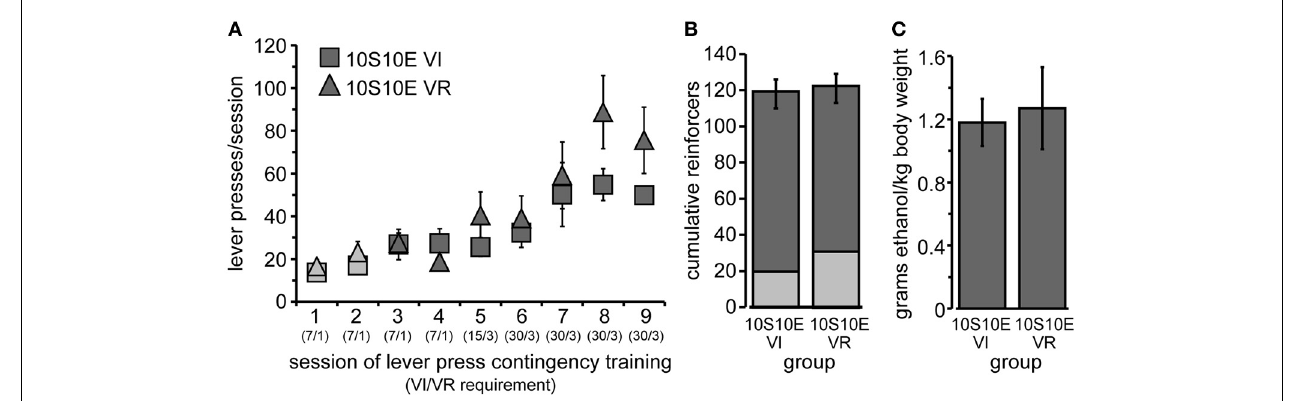
FIGURE 1 | Training of 10S10E groups. (A) Lever pressing increased similarly across training sessions for the two groups, 10S10E VI (squares) and 10S10E VR (triangles). Symbols for 10S-reinforced sessions are filled with lighter gray; those for 10S10E-reinforced sessions are darker gray. The numbers in parentheses beneath the session numbers on the x-axis indicate the programmed reinforcement criteria in effect for each group during that session (average time interval, in seconds, before a press yielded reinforcer